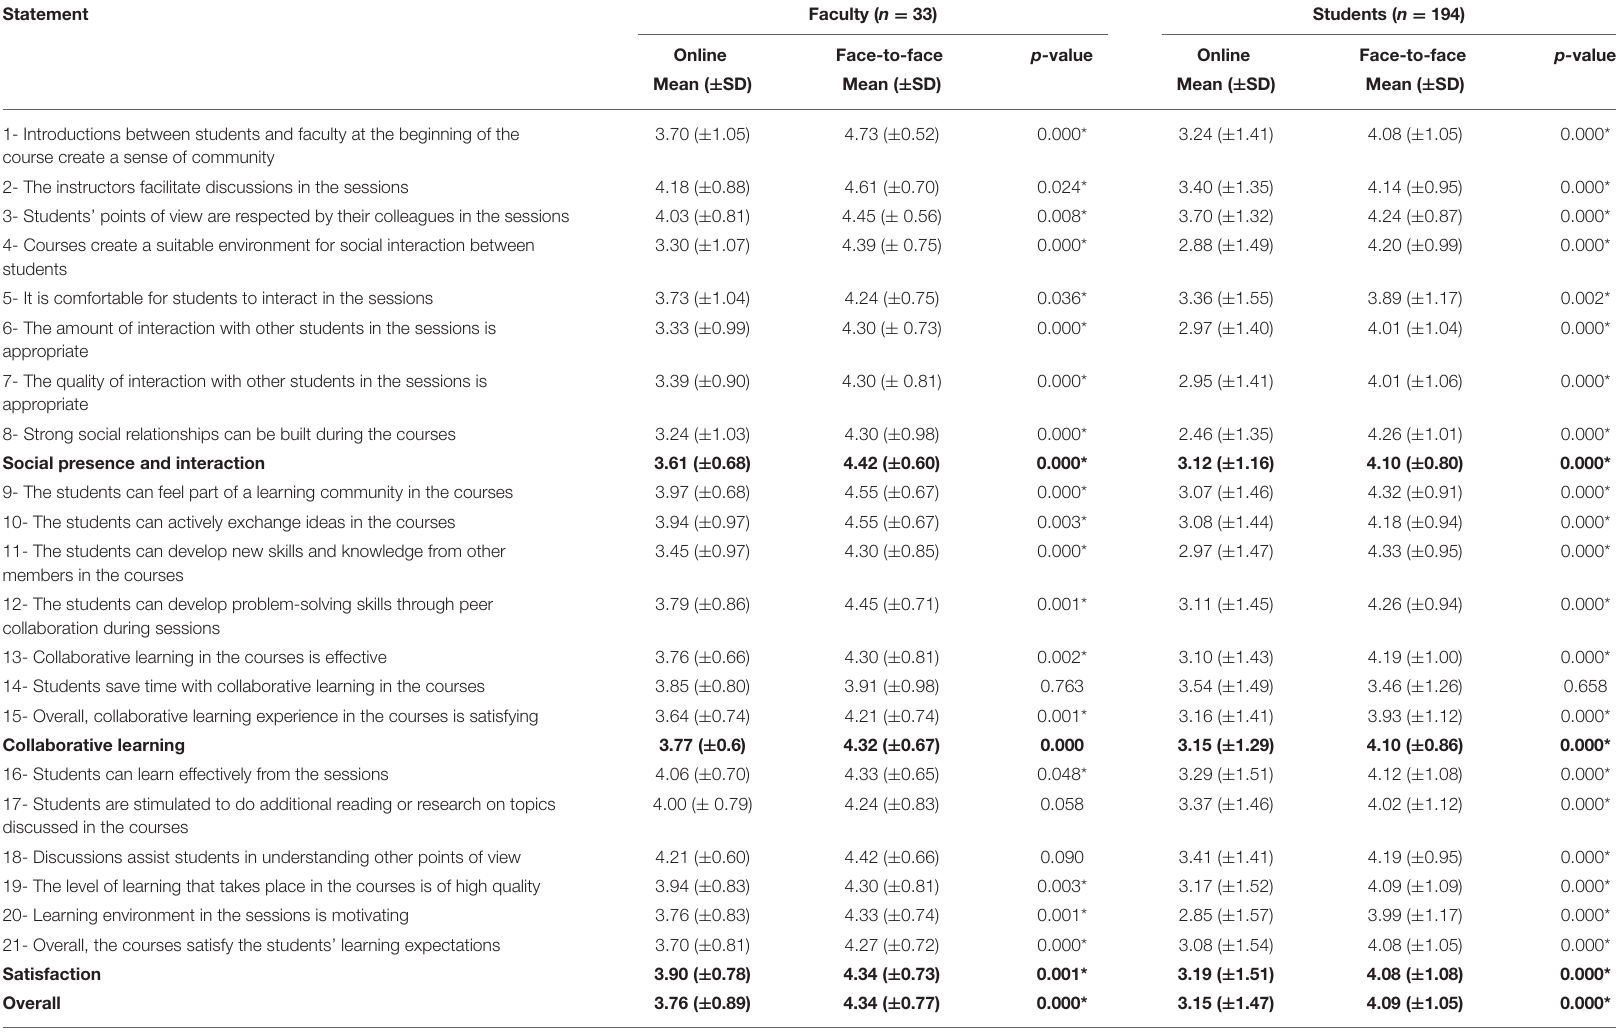
TABLE 1 | Comparison between responses of faculty and students on online and face-to-face